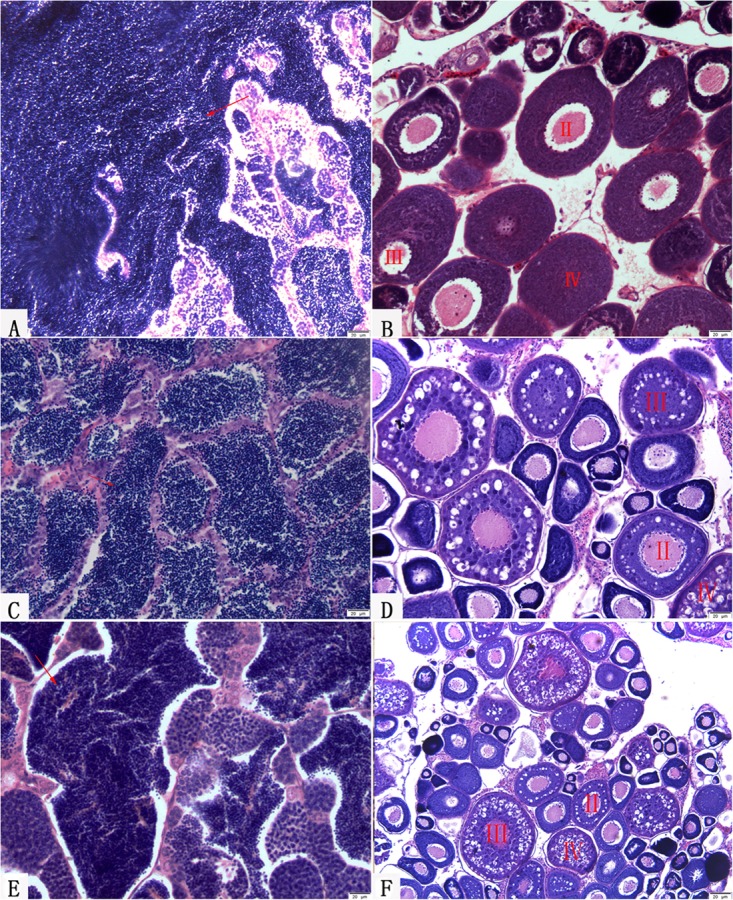
Gonadal structure of BSB, KOC, RCC-L, and GF-L. (A) Mature testis of BSB containing mature spermatozoa, spermatids and spermatogonia. (B) Mature ovary of KOC including II-phase, III-phase, and IV-phase oocytes. (C) Mature testis of RCC-L containing mature spermatozoa, spermatids and spermatogonia. (D) Mature ovary of RCC-L including II-phase, III-phase, and IV-phase oocytes. (E) Mature testis of GF-L containing mature spermatozoa, spermatids and spermatogonia. (F) Mature ovary of GF-L including II-phase, III-phase, and IV-phase oocytes. Bar = 20 μm.